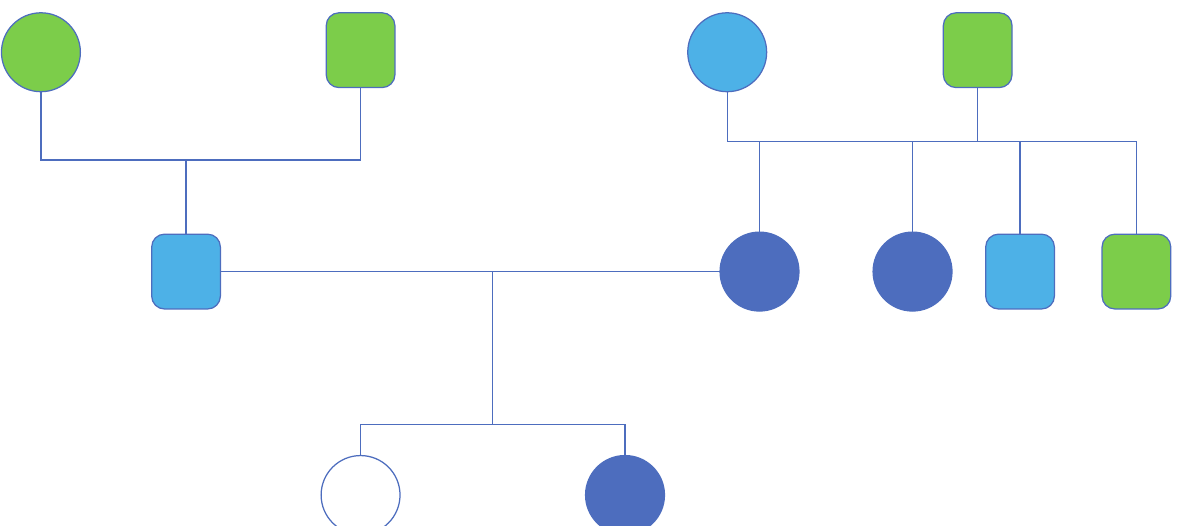
Figure 3: Pedigree of the family starting from the grandparents. The circles represent women; the squares represent men; the green color represents healthy people who does not fulfill criteria for vestibular migraine or M´eni`ere’s disease; the light blue color represents people with the history of migraine without vertigo; the blue color represents people who fulfills criteria for vestibular migraine; the white color represents people who fulfills criteria for definite M´eni`ere’s